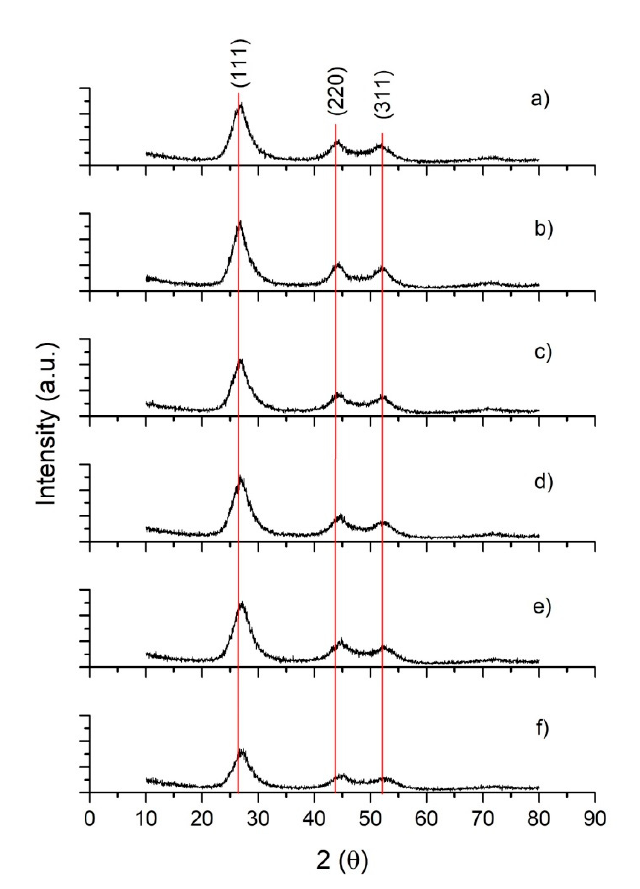
Figure 1. XRD patterns of CdS ( a ) and Zn x Cd 1 − x S samples: x = 0.05 ( b ), 0.10 ( c ), 0.15 ( d ), 0.20 ( e ) and 0.25 ( f ). Red lines correspond to the CdS (JCPDS 03-065-2887).